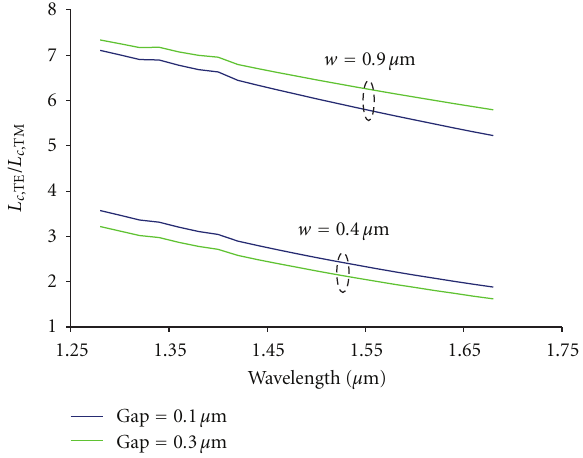
Figure 5: The ratio between TE and TM coupling lengths as a function of wavelength, for various waveguide widths and gap sizes.